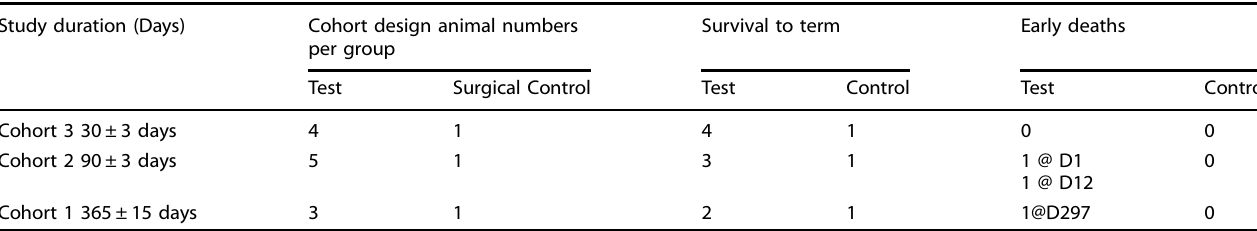
Table 1. Overall study